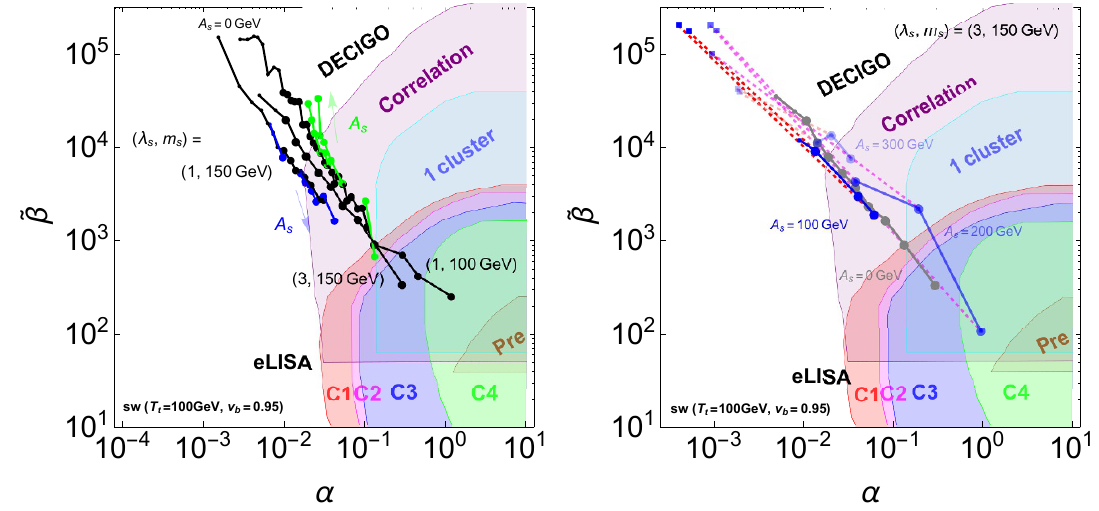
Figure 10 . Detectability of GWs as a function of (cid:21) sh from the two-step PT ((cid:10) 0 ! (cid:10) s ! (cid:10) h ) in the ( (cid:11) , e (cid:12) ) plan. (Left panel: second-(cid:12)rst order pattern): for each point, the (cid:12)rst order EWPT ((cid:10) s ! (cid:10) h ) is labelled by the circle point which corresponds to plots in (cid:12)gure 7 (left) and a green triangle point in (cid:12)gure 8. Black lines of A s = 0 are connected for ( (cid:21) s , m s [GeV])=(1, 100), (1, 150), (3, 150). Green and Blue lines of (cid:12)nite A s correspond to the parameters in (cid:12)gure 7 (left). (Right panel: (cid:12)rst-(cid:12)rst order pattern): for each point, the two sources of the (cid:12)rst order phase transition from the other (cid:12)rst order PT ((cid:10) 0 ! (cid:10) s ) and the (cid:12)rst order EWPT ((cid:10) s ! (cid:10) h ) are labelled respectively by the square and circle points, connected by a dashed line which correspond to plots in (cid:12)gure 7 (right) and a green star point in (cid:12)gure 8. The solid lines for A s [GeV] = 0 ; 100 ; 200 ; 300 correspond to the parameters in (cid:12)gure 7